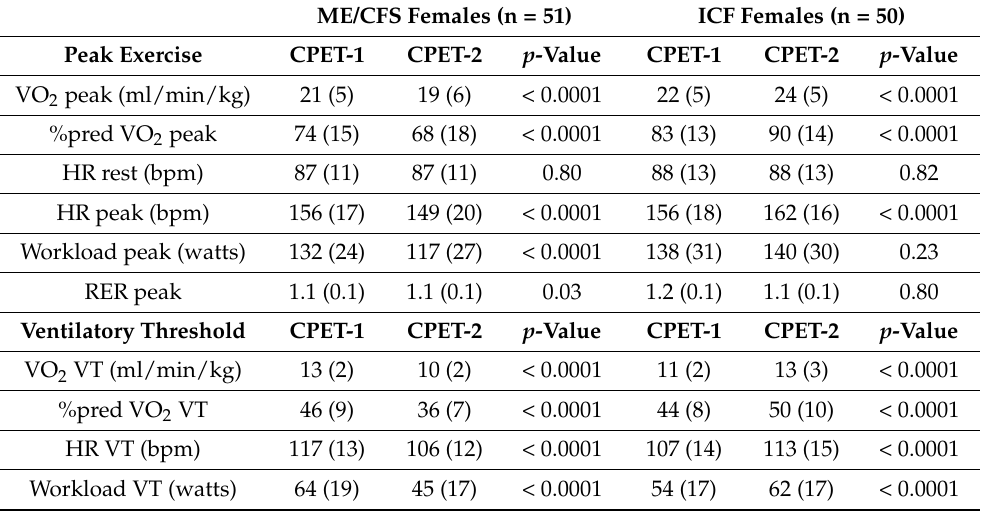
Table 2. CPET-1 and CPET-2 variables for female ME/CFS patients (left side) and female ICF patients (right